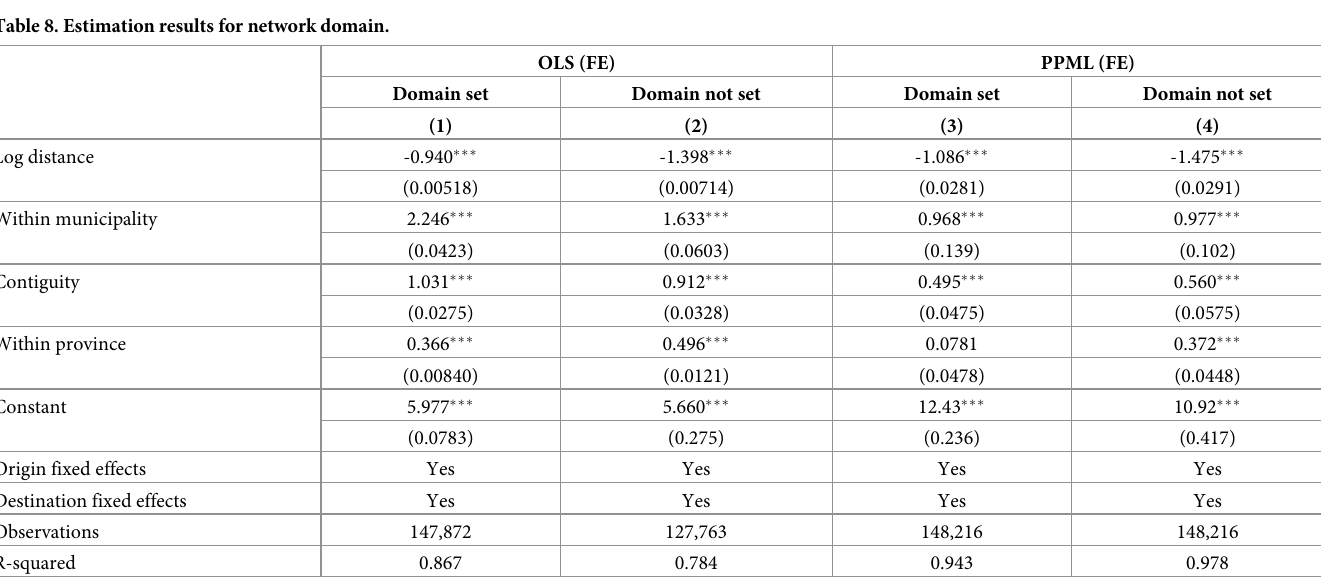
Table 8. Estimation results for network